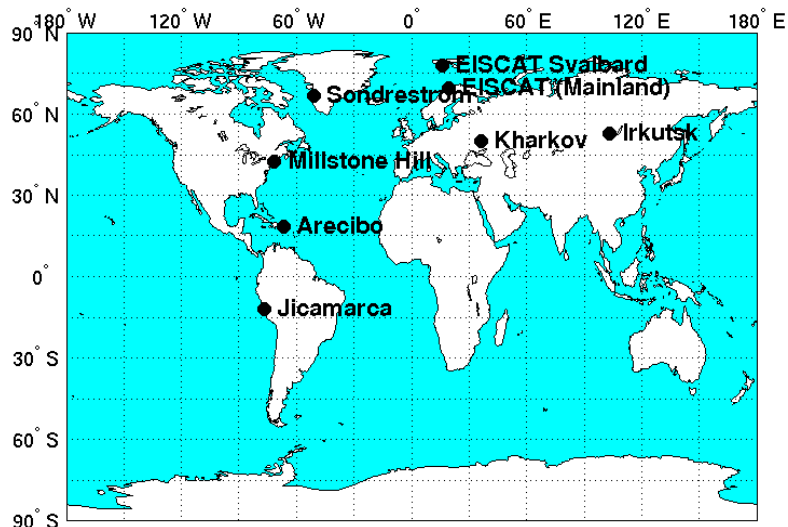
Fig. 1. Locations of incoherent scatter radars. Table 1. Radar information. Radar Invar. lat. Geod. lat. Geod. lon. L-shell Time of sunrise Time of sunset at 350km, UT at 350km, UT EISCAT Svalbard 74.87 ◦ 78.1 ◦ N 16.0 ◦ E ∼ 20 – – Sondrestrom 73.17 ◦ 67.0 ◦ N 309.1 ◦ E ∼ 14 – – EISCAT Mainland 66.40 ◦ 69.6 ◦ N 19.2 ◦ E ∼ 6.5 – – Millstone Hill 53.40 ◦ 42.6 ◦ N 288.5 ◦ E 2.8 08.34 01.19 Irkutsk 45.89 ◦ 52.9 ◦ N 103.1 ◦ E 2.1 19.67 14.55 Kharkov 45.75 ◦ 50.0 ◦ N 36.2 ◦ E 2.1 00.78 18.41 Arecibo 32.18 ◦ 18.3 ◦ N 293.3 ◦ E 1.4 08.83 00.01 13.90 ◦ 12.0 ◦ S 283.1 ◦ E 1.1 10.00